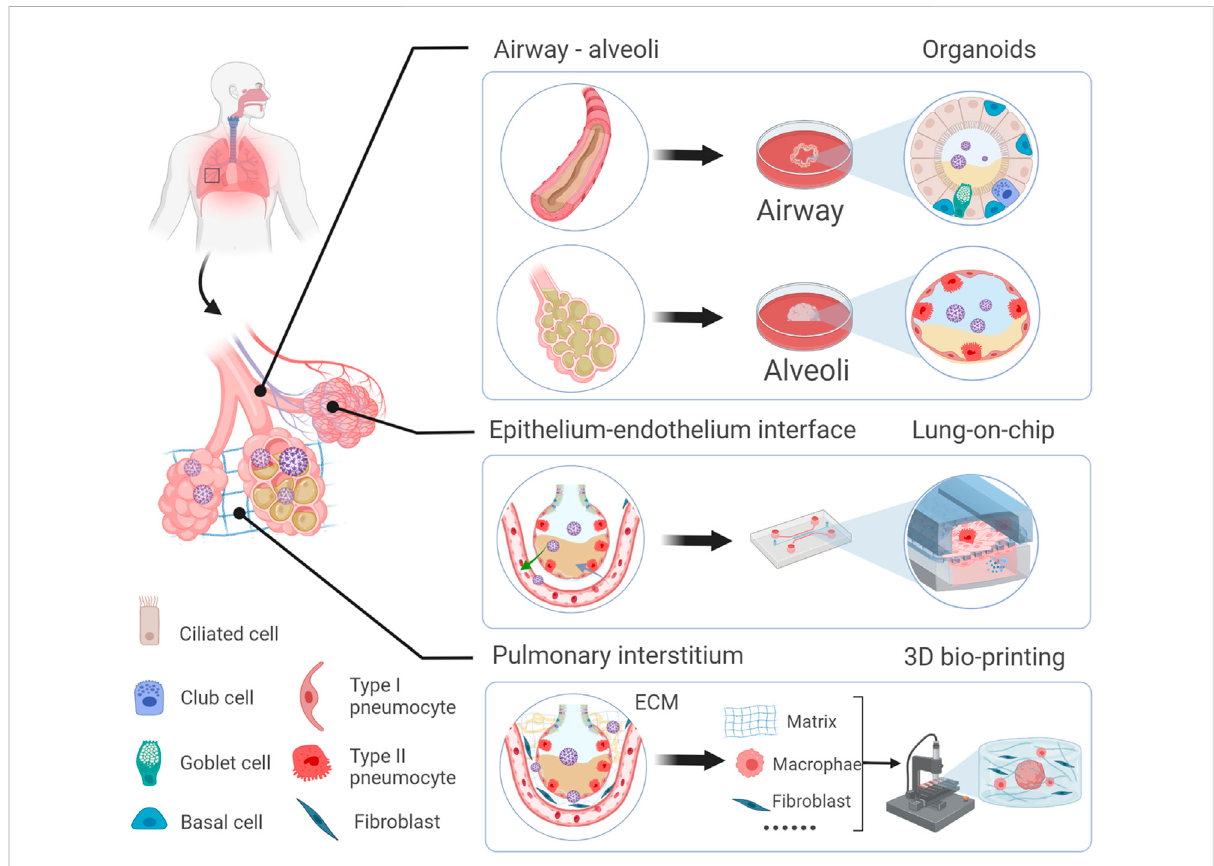
FIGURE 1 Schematic representation of novel 3D models to mimic in vivo the physiology and pathophysiology of different lung regions. Different 3D cell culture models (organoid, organ-on-a-chip, and 3D bioprinting) have their own advantages which could mimic the structure and function of different lung regions (airway, alveoli, a thin epithelial-endothelial barrier, and pulmonary